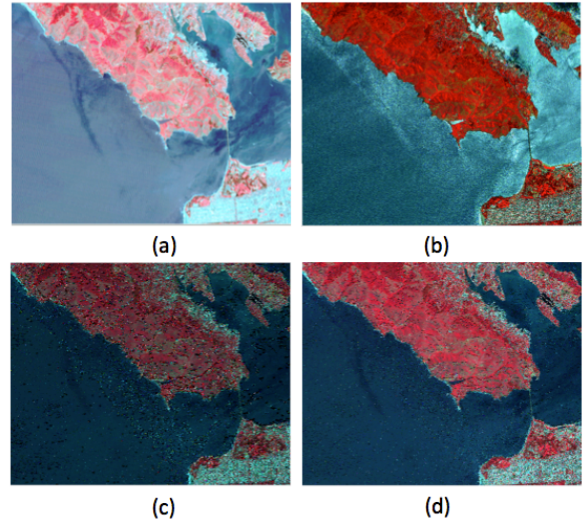
Figure 2. (a) FCC of the original spectral bands, (b) FCC of the WV-2 bands, (c) FCC of the bands obtained from 5 clusters and 3 x 3 windows, and (d) FCC of the bands obtained from 25 clusters and 5 x 5